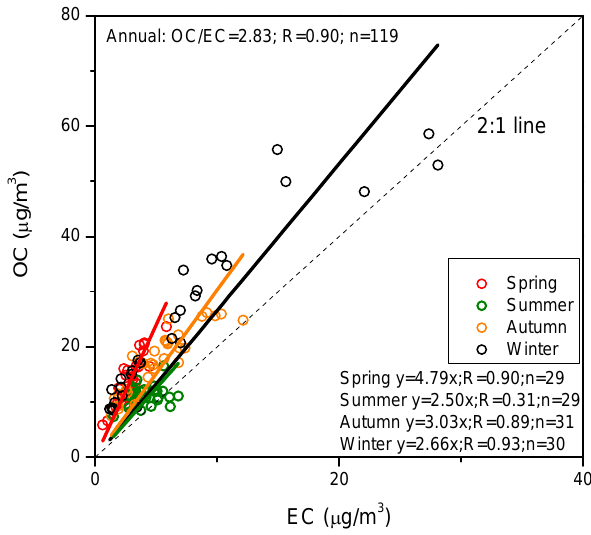
Figure 3 Fig. 3. Scatter plot showing the correlation between OC ( y axis) and EC ( x axis) in PM 2 . 5 collected from Beijing. Different symbols denote the four seasons. Linear regression equations are given in the annual and seasonal